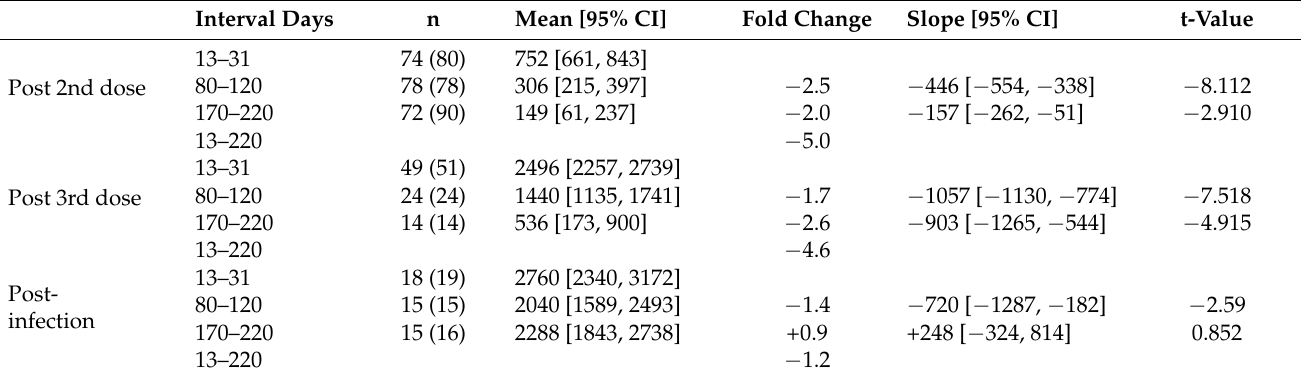
n: number of individuals with at least one observation per time interval (total number of observations). Mean, slope, t-value, and 95% CI from linear mixed model